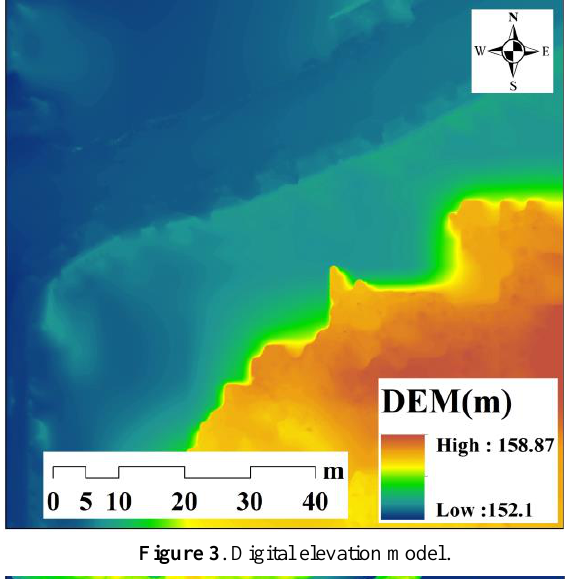
Figure 3 . Digital elevation model.